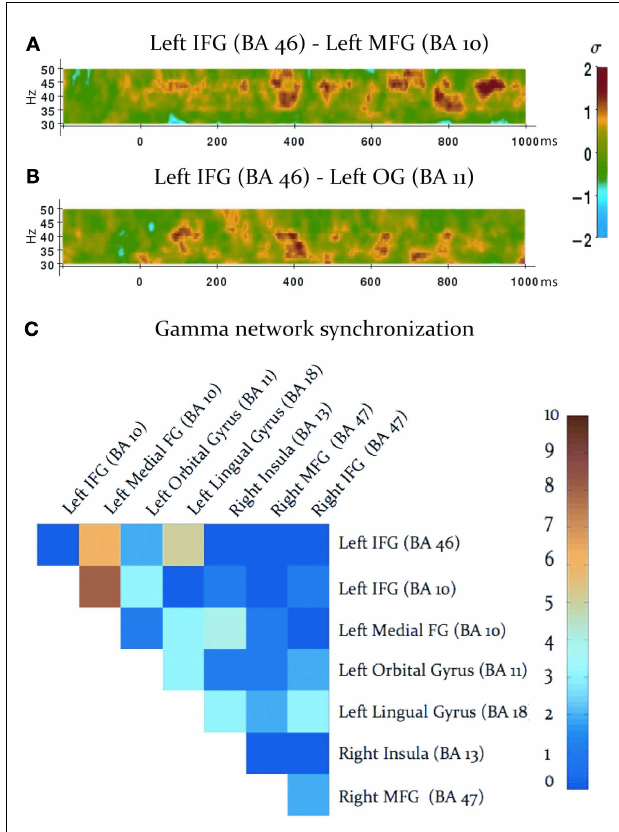
FIGURE 2 | Gamma-band synchronization among activated regions during the verb generation task. (A,B) Examples of observed patterns of gamma-band phase locking between activated regions, legend at right. Note that instances of inter-regional gamma-band synchronization are transient, and periodically recur at a theta rate. (C) Inter-regional gamma-band synchronization throughout the activated network, legend at right. Each square indicates the number of statistically significant instances of gamma-band synchronization between each pair of activated regions, indicated at the top and right (IFG: inferior frontal gyrus; MFG: medial frontal gyrus; OG: orbital